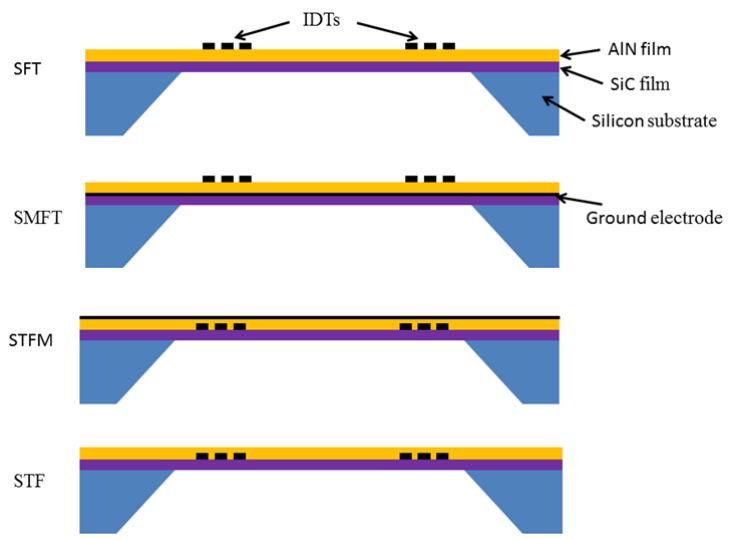
Figure 3. The four coupling